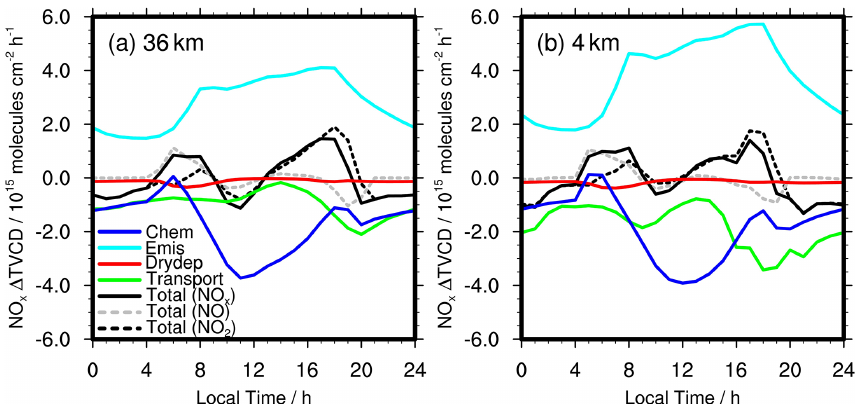
Figure 9. Contributions of emission, chemistry, transport, and dry deposition to NO x TVCD diurnal variations over the 11 inland Pandora sites (Table S1 and Fig. 1) on weekdays in July 2011 for the (a) 36km and (b) 4km REAM simulations. “Chem” refers to net NO x chemistry production; “Emis” refers to NO x emissions; “Drydep” denotes NO x dry depositions; “Transport” includes advection, turbulent mixing, lightning NO x production, and wet deposition. “Total (NO x )” is the hourly change in NO x TVCDs ((TVCD) = TVCD t + 1 − TVCD t ). “Total (NO 2 )” is the hourly change in NO 2 TVCDs, and “Total (NO)” is the hourly change in NO